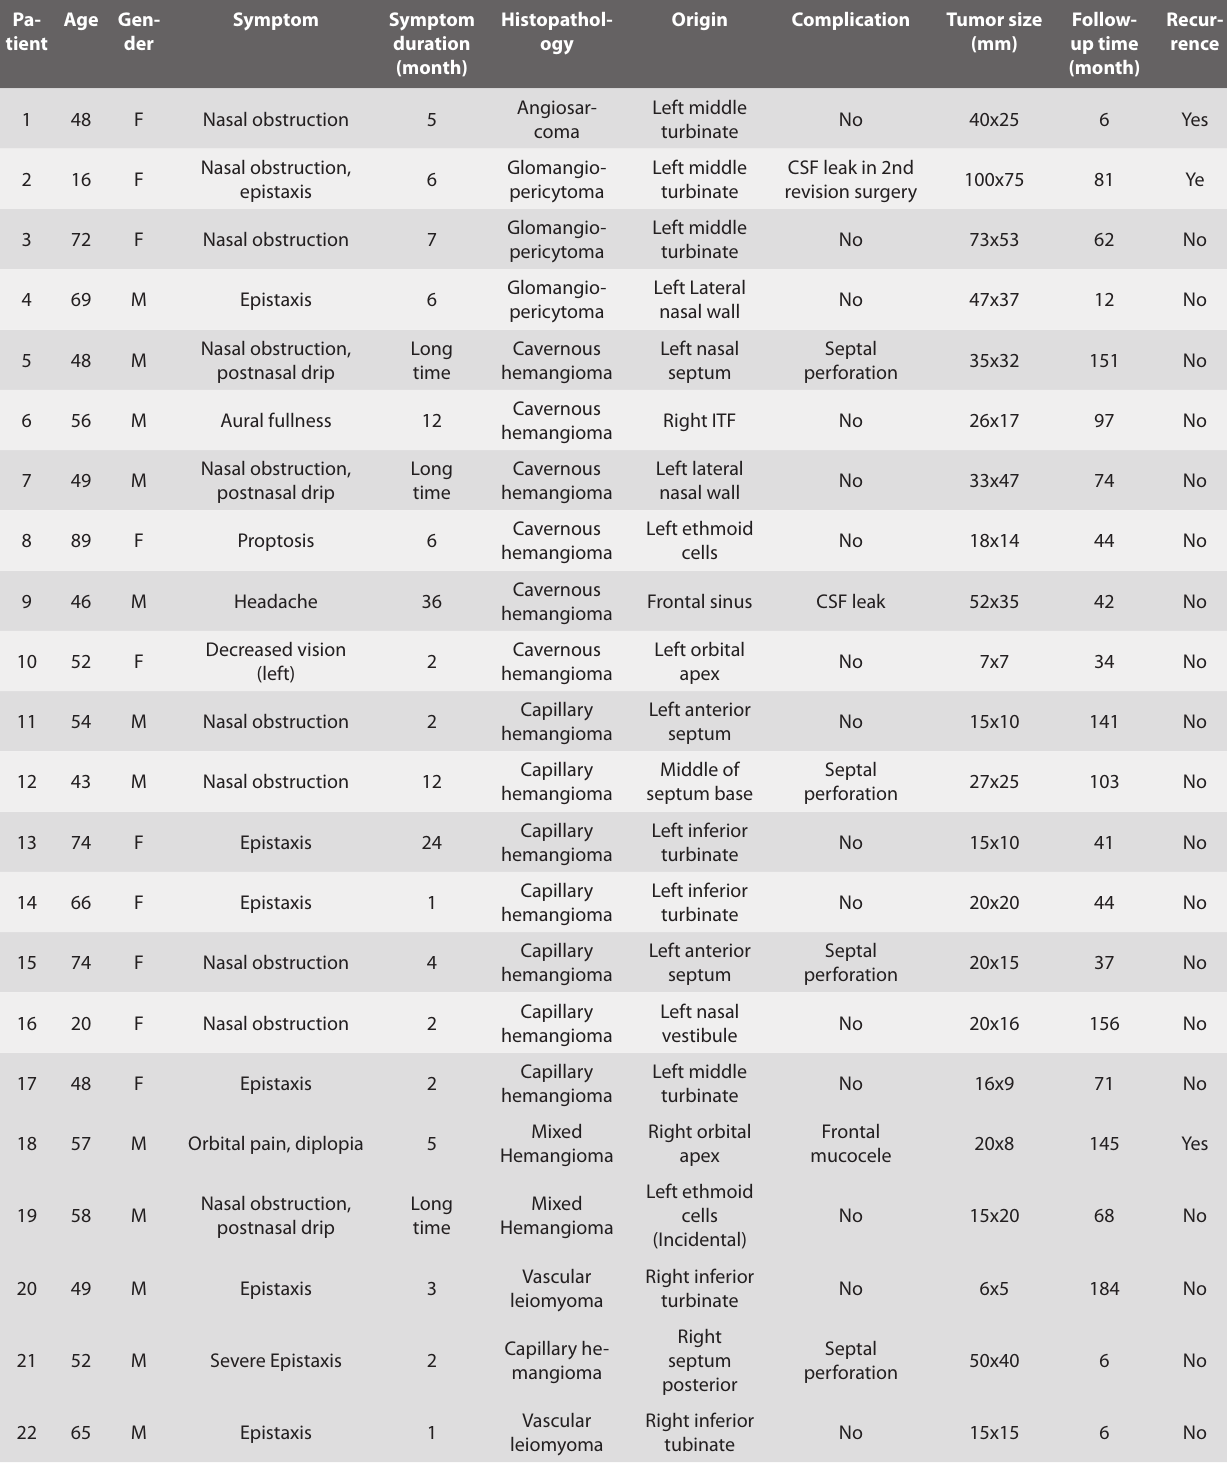
Table 1. Characteristics of the patients with sinonasal vascular tumour. Pa- Age Gen- tient